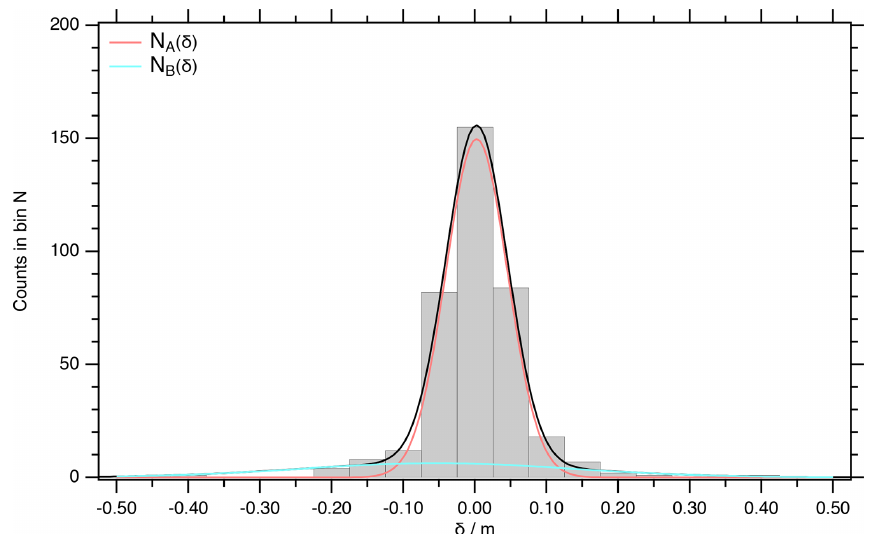
Figure D1. Histogram of the difference data with linear interpolation δ i = ( D i + 1 − D i − 1 ) / ( d i + 1 − d i − 1 )( d i − d i − 1 ) + D i − 1 − D i for the match points between EGRIP and